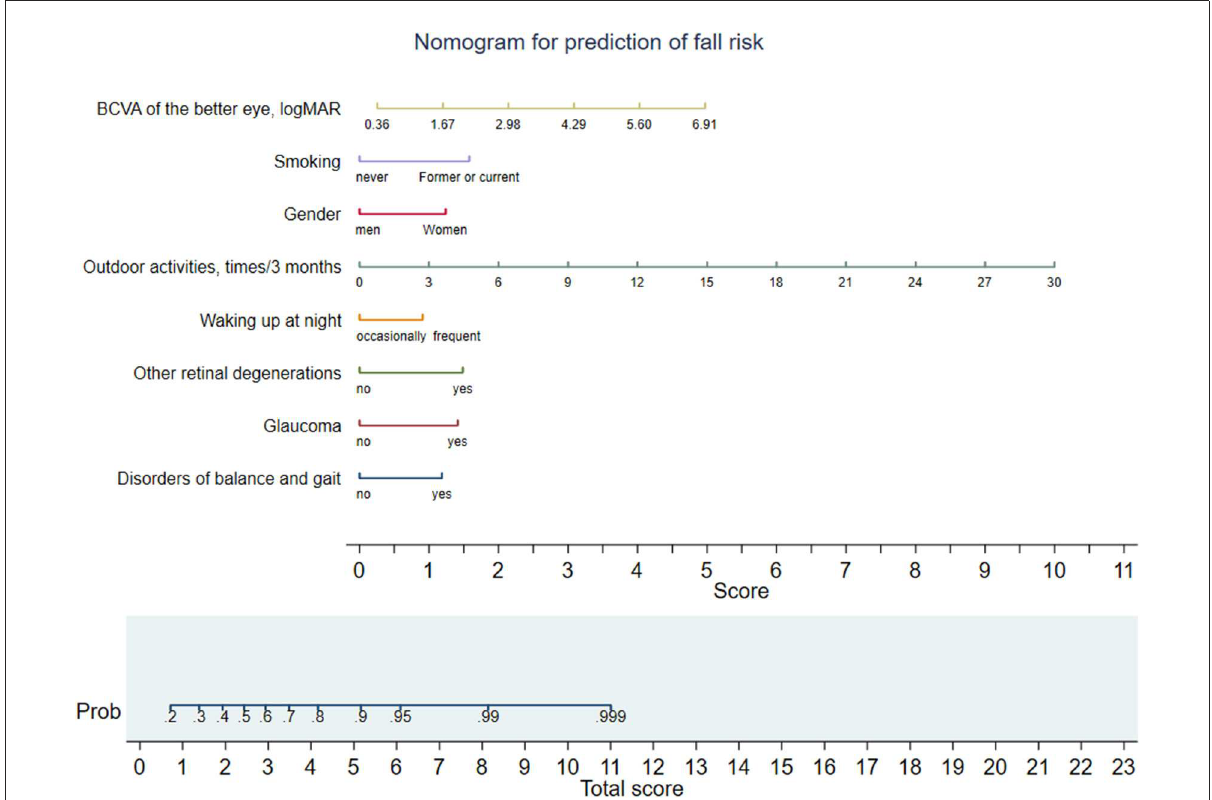
FIGURE1 Nomogram for fall risk prediction of elderly patients with visual impairment. Different values of each variable correspond to different positions in the nomogram. Draw a line from the position of cach variable to the points axis for acquiring points of this variable. Points of different variables are summed to yield a total score that can be converted into predicted probability of fall based on the total score axis of the nomogram. BCVA, best-corrected visual acuity.